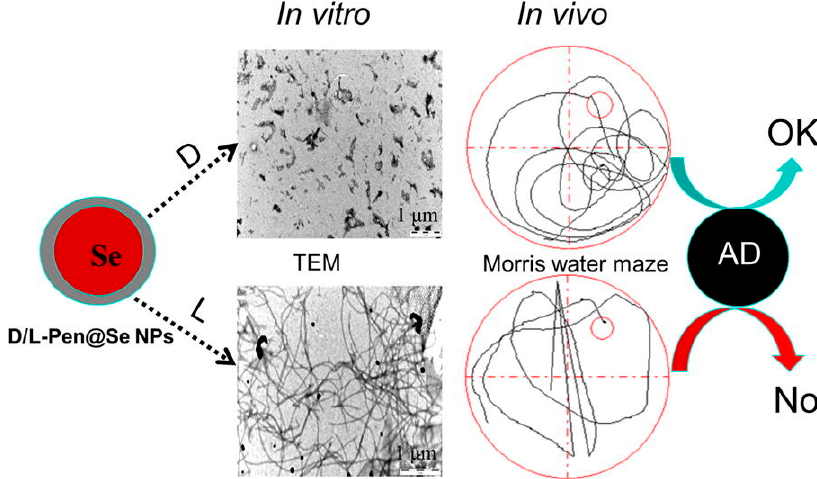
Figure 6. Inhibition effects of chiral penicillamine-capped NPs both in vitro and in vivo. Reprinted with permission from [69], Copyright Elsevier,